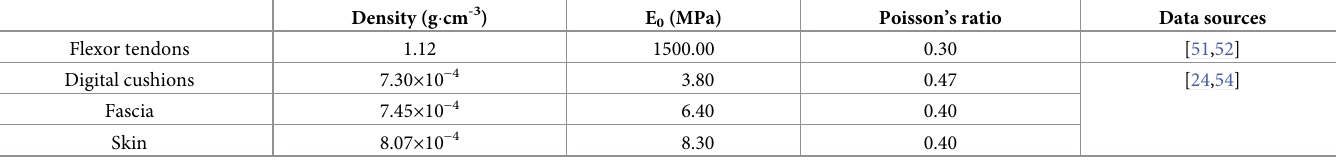
Fig 1. Design rationale of a bio-inspired foot. 1—digital cushions, 2—fascia, and 3—skin [53]. https://doi.org/10.1371/journal.pone.0236324.g001 Table 1. Mechanical parameters of ostrich foot tissues. Densities, elasticity moduli (E 0 ) and Poisson’s ratios of ostrich foot flexor tendons, digital cushions, fascia and skin. A spring mechanism was used to simulate the functions of the MTP joint, while the stiffness coefficient (K 0 ) was 100 N � mm -1